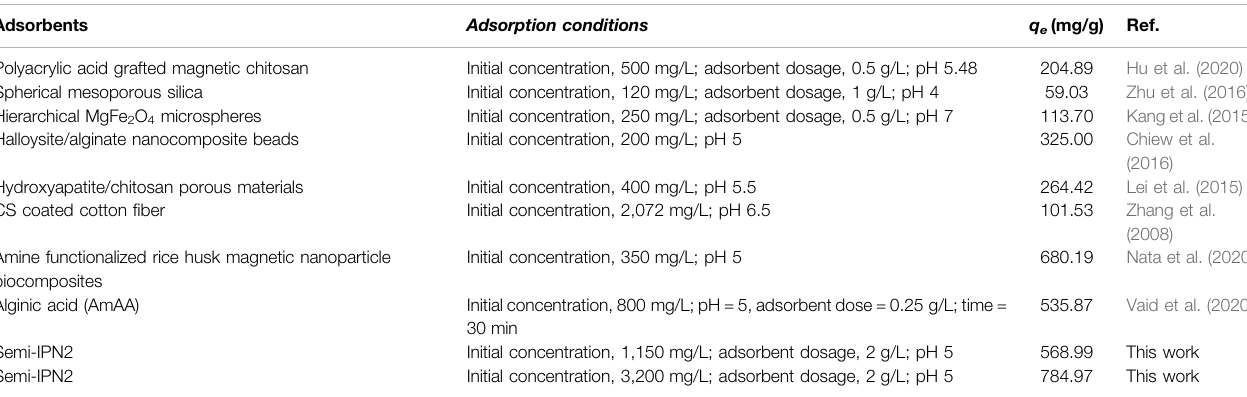
TABLE 2 | Comparison of the adsorption capacities of different adsorbents for Pb(II).